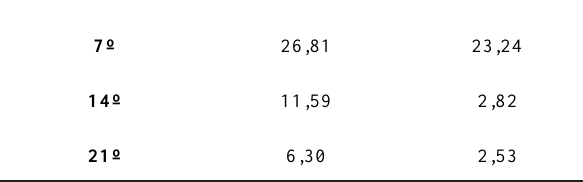
P=0.033 when compared with the respective control (G1)